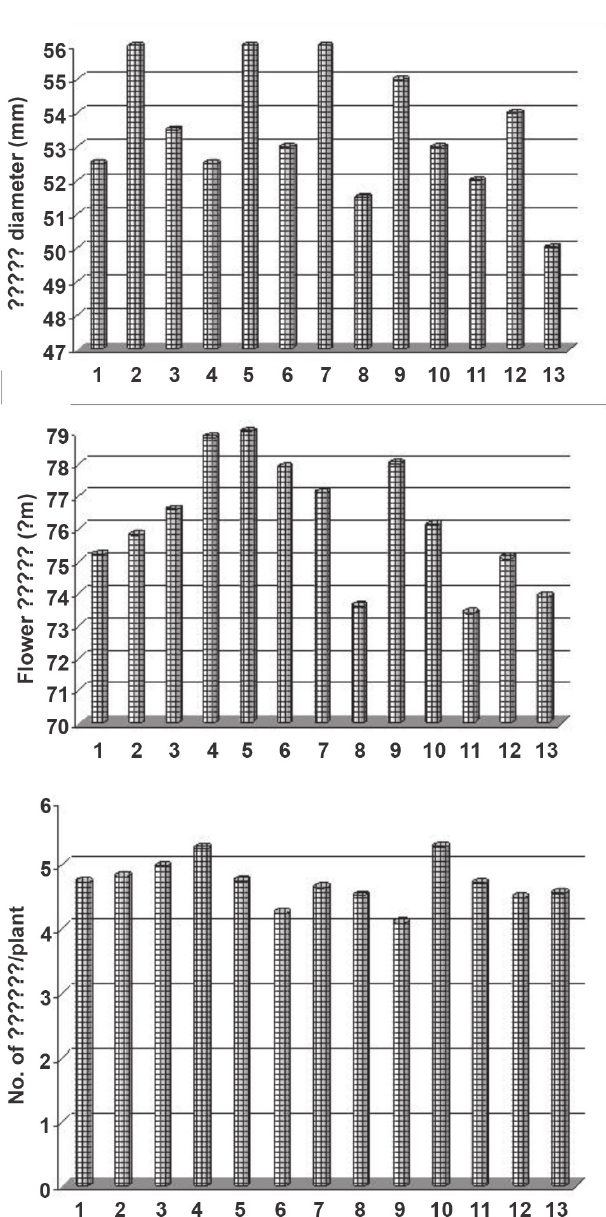
Figure 1: Effect of foliar application with commercial compounds on inflorescence diameter (mm), flower stalks length (cm) and number of seeds stalk/plant (mean of the 2 seasons) Treatments from 1 to 13: Shetocare, Amica, Caboron, Elga 600, Amino X, Hummer, Union Zn, Union Mn, Union Feer, Shams K, Boron, Magnesium and control,